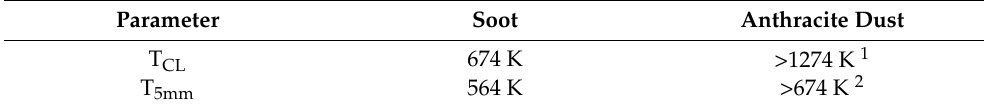
Table 5. Ignition indices of tested